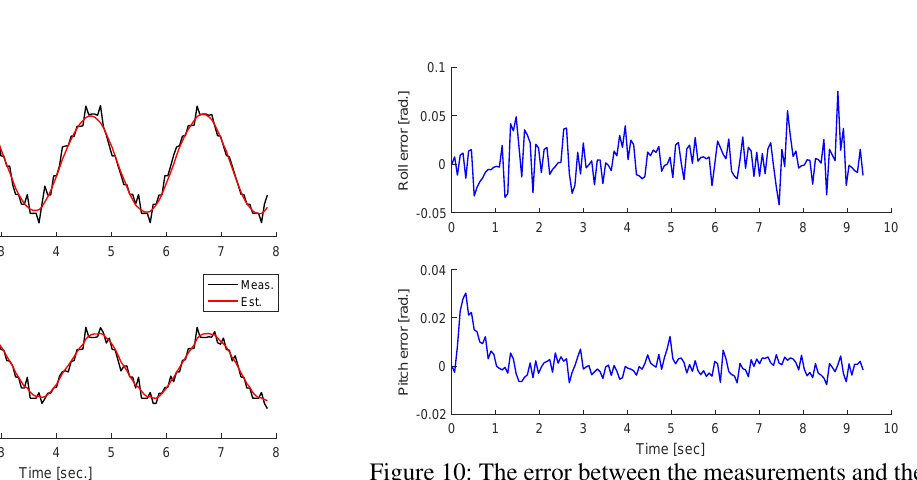
Figure 7: The measured and estimated values of the roll case.